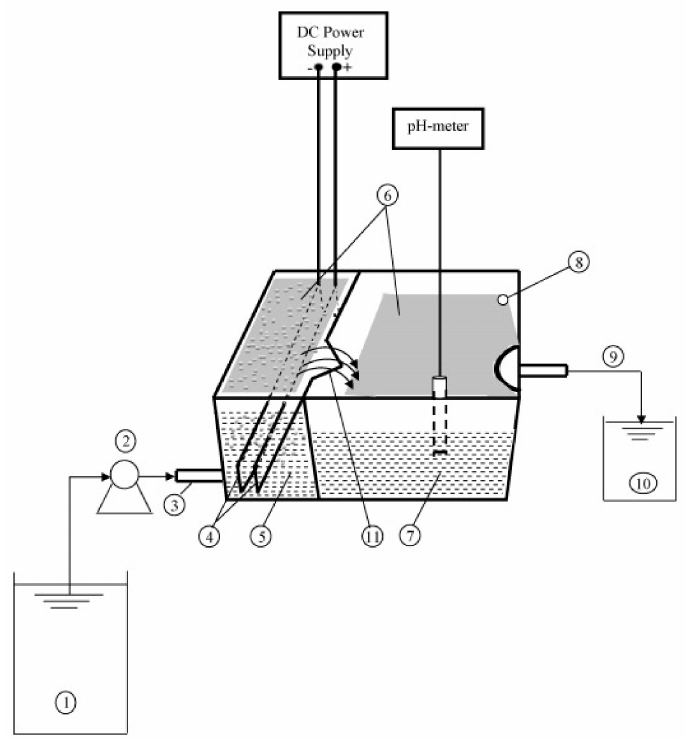
Figure 12. Experimental setup of continuous EC cell: ( 1 ) wastewater tank; ( 2 ) peristaltic pump; ( 3 ) in- let of the first compartment; ( 4 ) electrodes; ( 5 ) first compartment; ( 6 ) sludge; ( 7 ) second compartment; ( 8 ) sludge exit (overflow); ( 9 ) treated effluent outlet; ( 10 ) treated water tank; ( 11 ) outfall